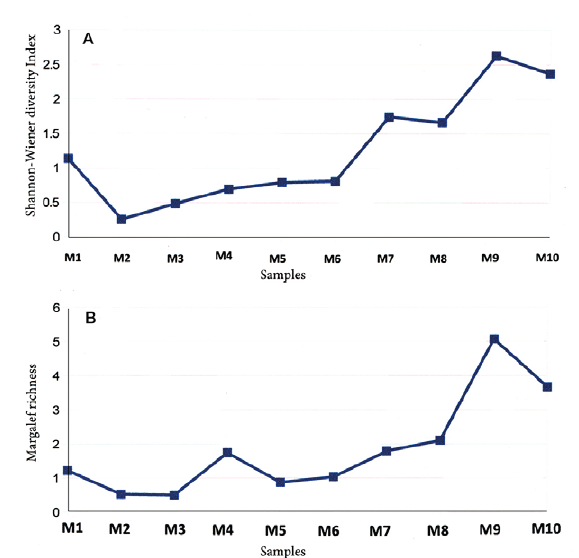
Fig. 7. – Diversity indices of surface sediment (present-day sam- ples). A, Shannon-Wiener diversity index. B, Margalef